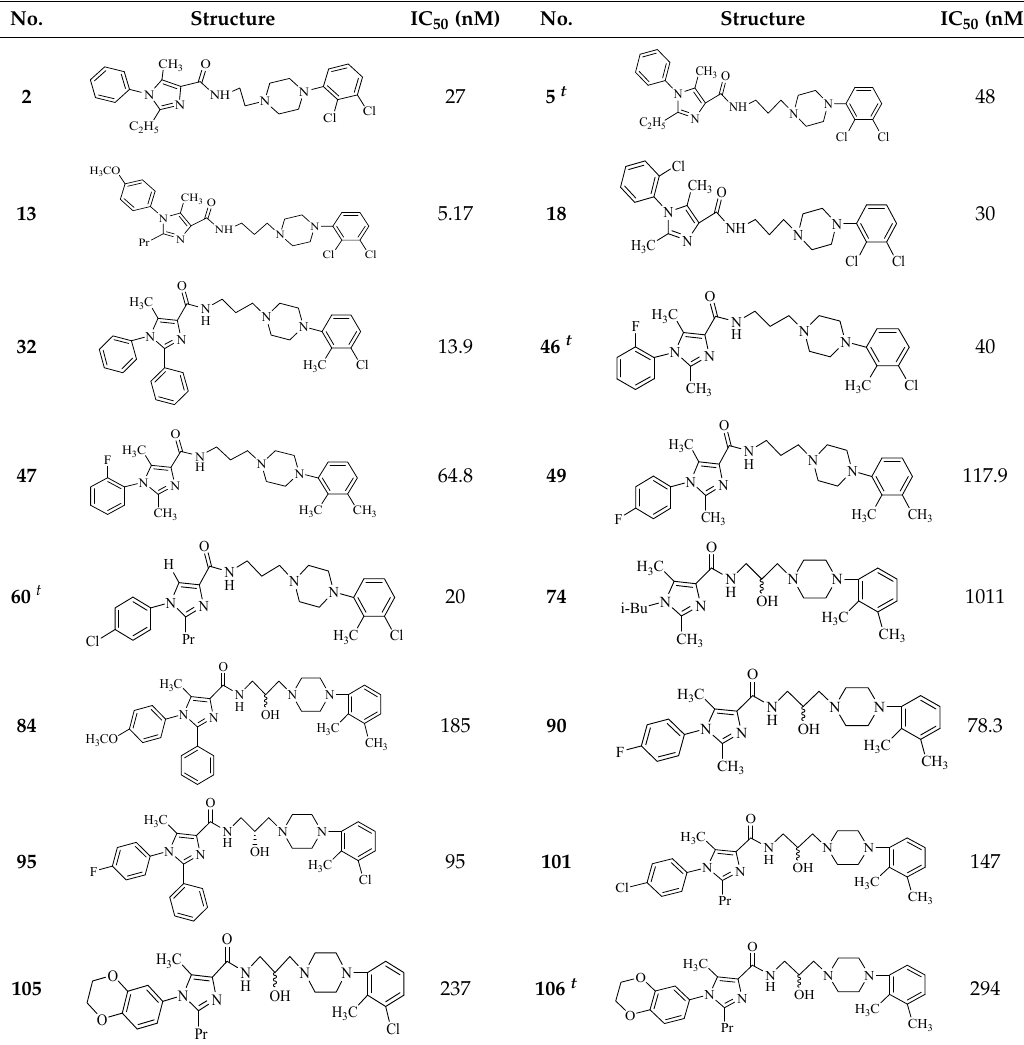
Table 1. Representative molecular structures and IC 50 values of arylpiperazine derivatives.